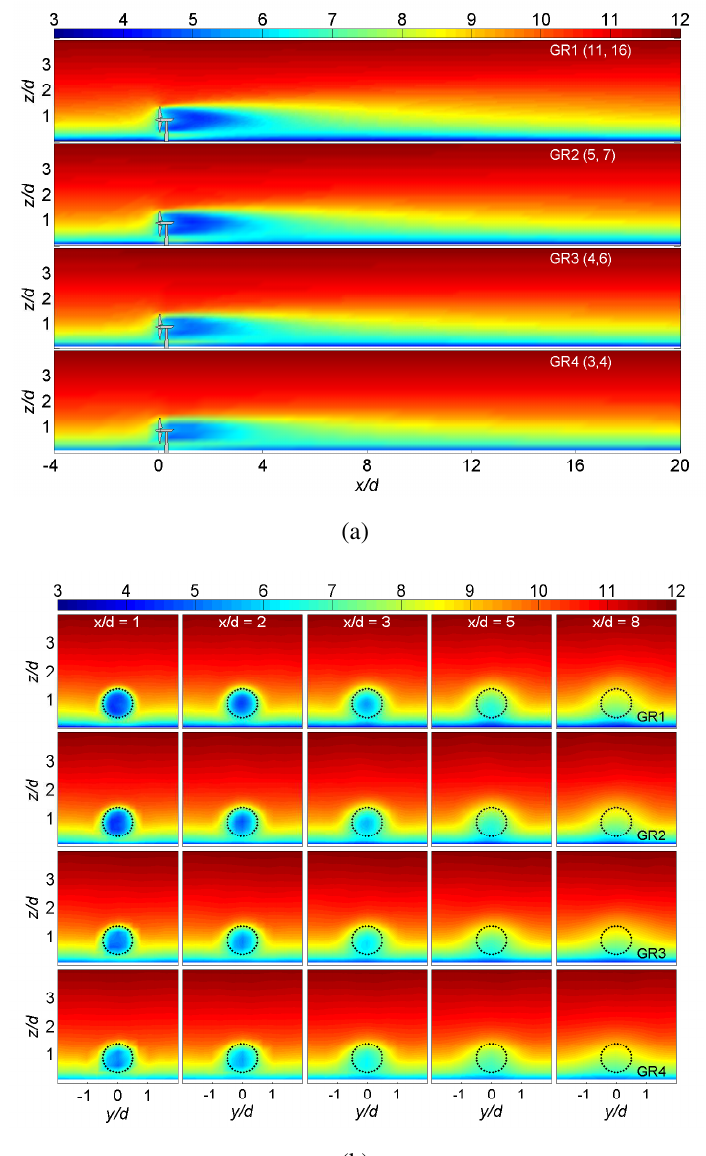
Figure 14. Contours of the streamwise velocity obtained from the LESs using different grid resolutions on the xz ( a ) and yz ( b )